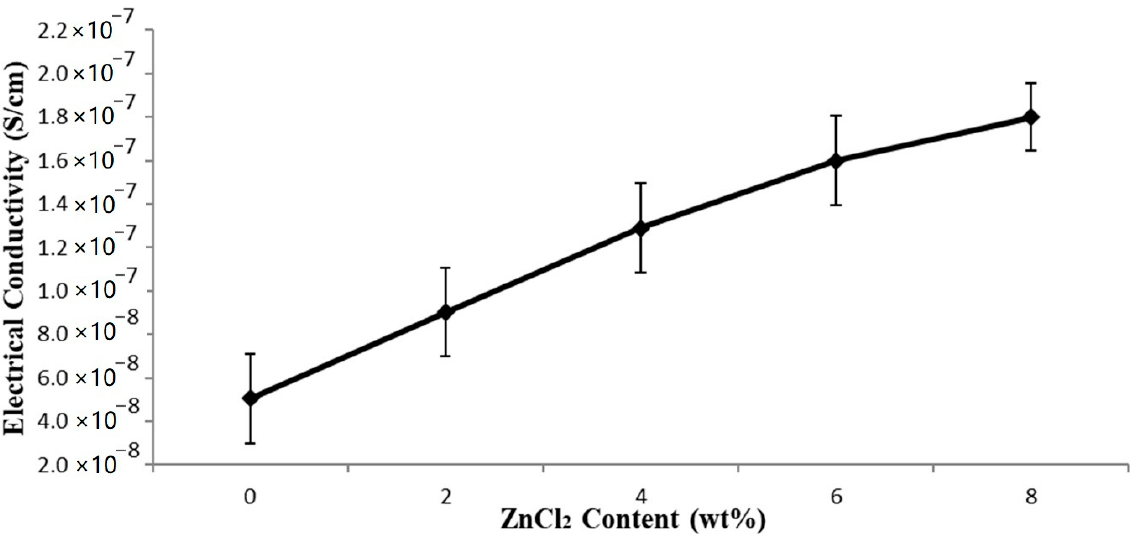
Figure 11. Effect of ZnCl 2 content on electrical conductivity of EVA/CWF